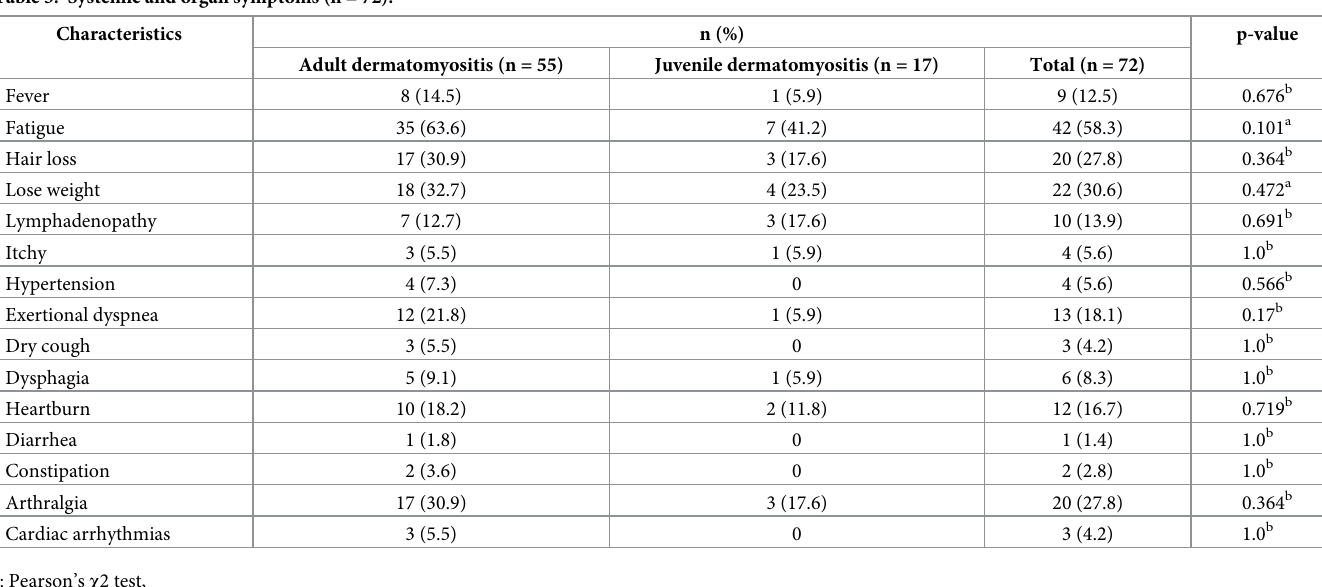
Table 3. Systemic and organ symptoms (n = 72). Characteristics